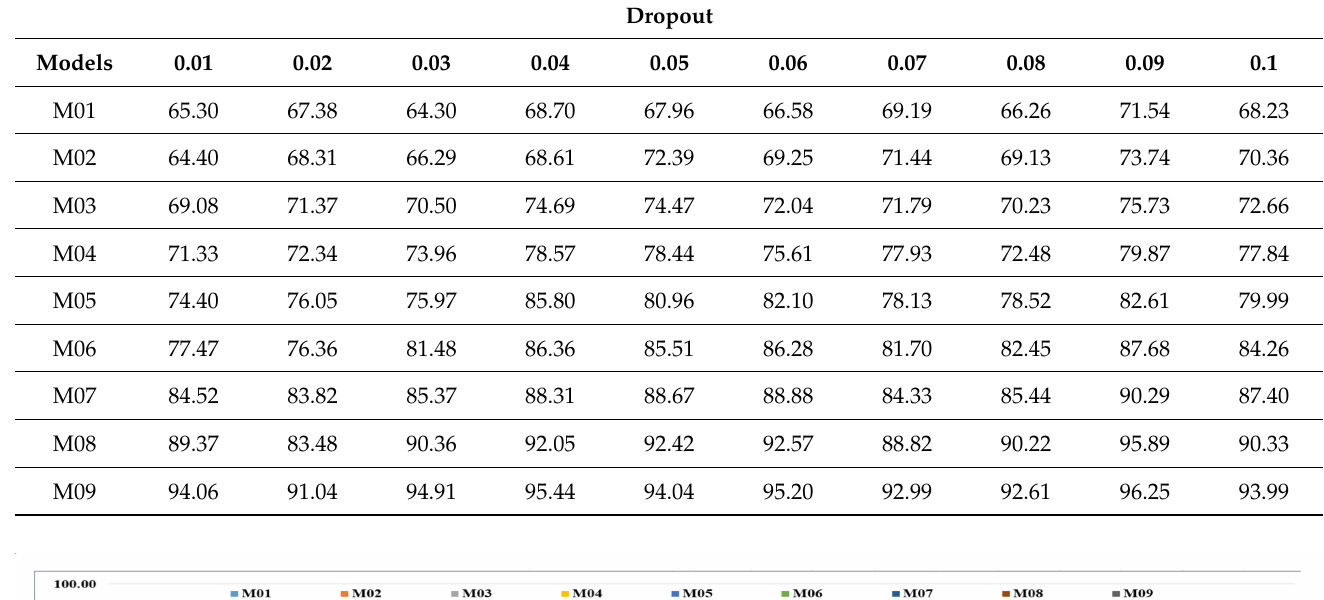
Table 10. Average classification accuracy (%) results for an embedding size of 400.